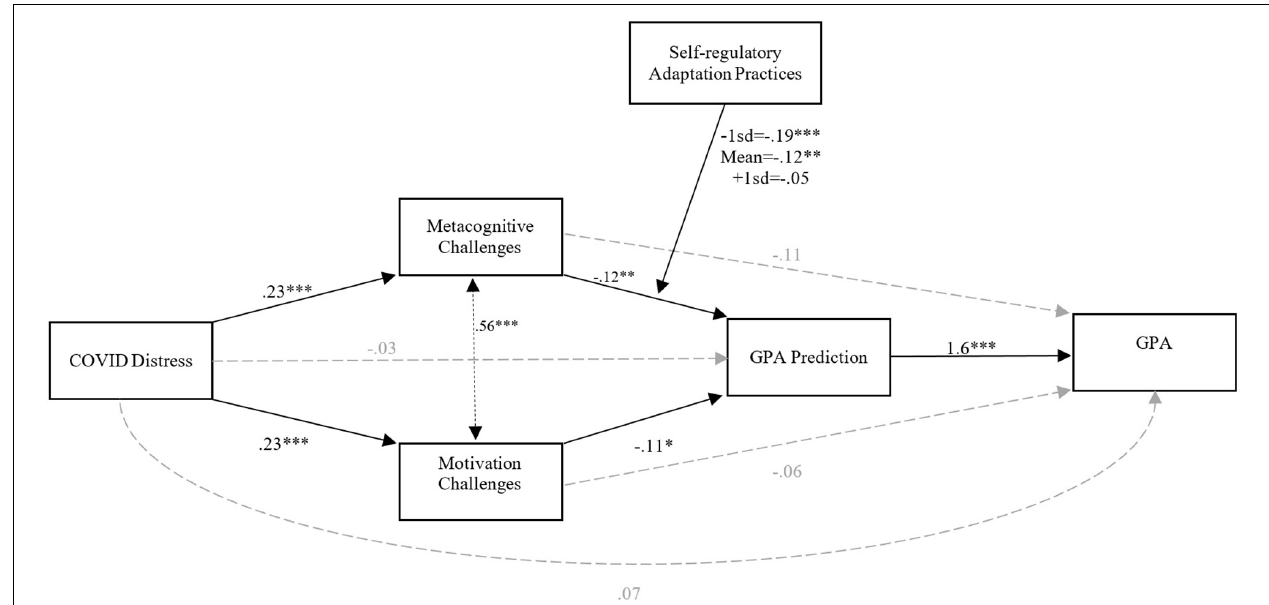
FIGURE 1 | Structural relationship between COVID-D (predictor), metacognitive and motivation challenges (parallel mediators), GPA-P (serial mediator), adaptation practices (moderator), and GPA (outcome): a conditional process path analysis ( N =